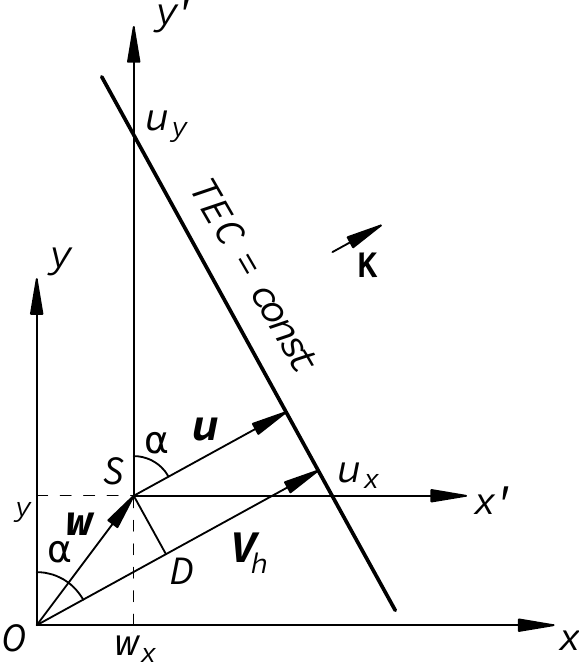
Fig. 8. The moving radio interferometer coordinate system (x 0 Sy 0 ) and the fixed coordinate system (xOy) : u 0 x and u 0 y are the velocities of intersection of the line T EC = const of the axes x 0 and y 0 in a moving coordinate system (x 0 Sy 0 ) and w x , w y are the x - and y - projections of the satellite displacement velocity w